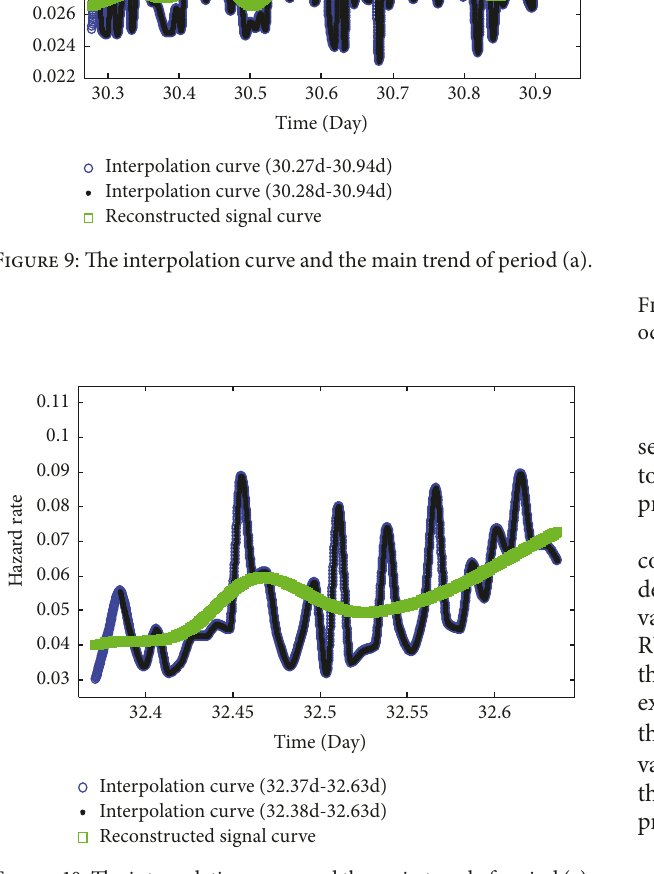
t e r a d r z a H a